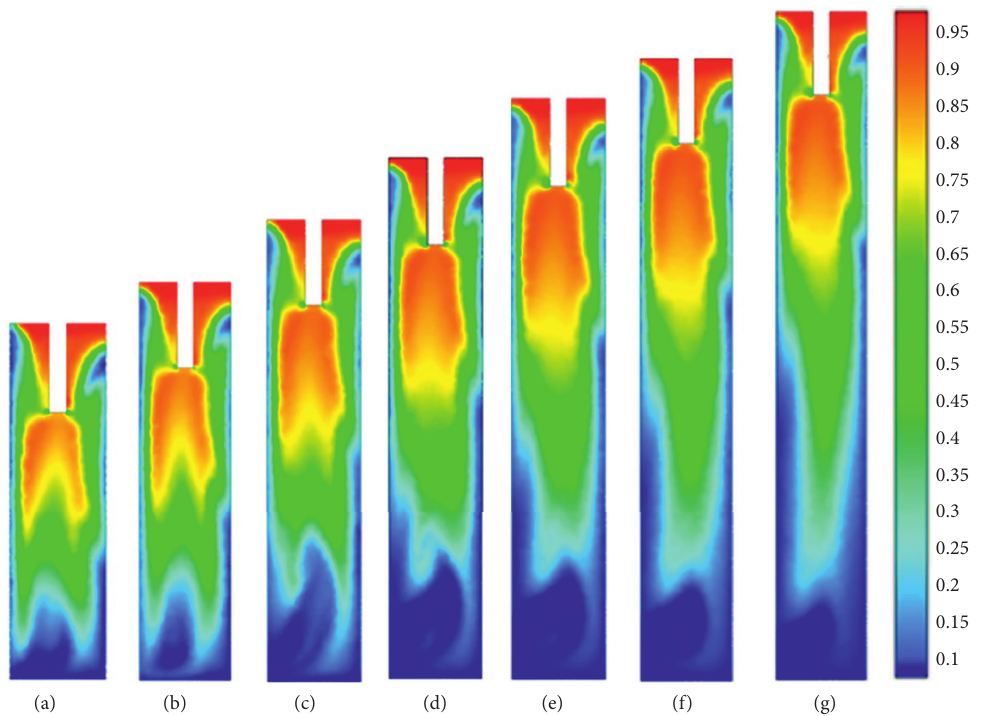
Figure 16: Gas volume distribution nephogram at different cylinder lengths. (a) l (e) l 2 � 100mm. (f) l 2 � 110mm. (g) l 2 �